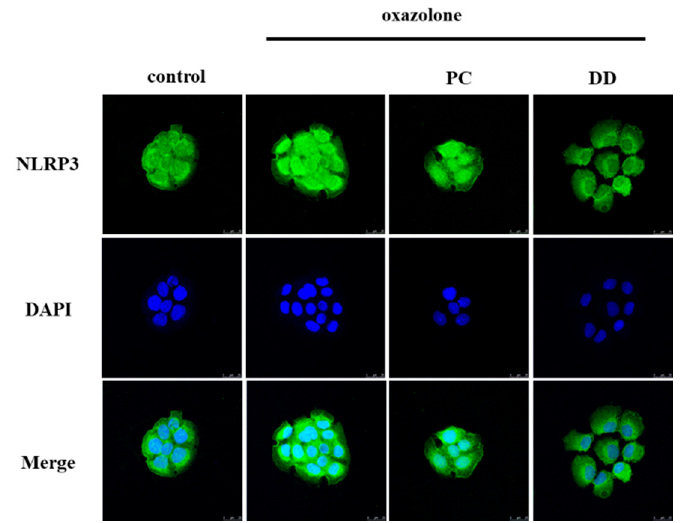
Figure 4. Fluorescent confocal microscopic images showing the localization of inflammasome components NLRP3 (green) in HaCaT cells. Table 1. Cytokine levels in oxazolone-treated HaCaT cells and PC/DD + oxazolone-treated cells.